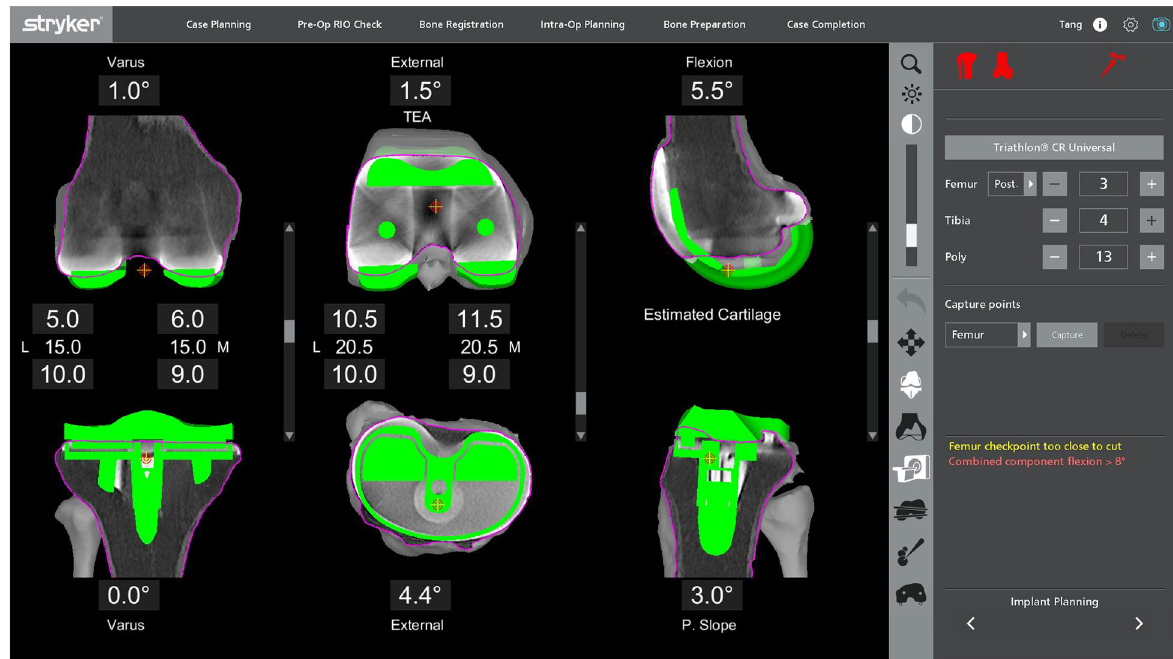
Fig. 7 Preoperative planning for a patient with an over‑sized femoral component with patella baja